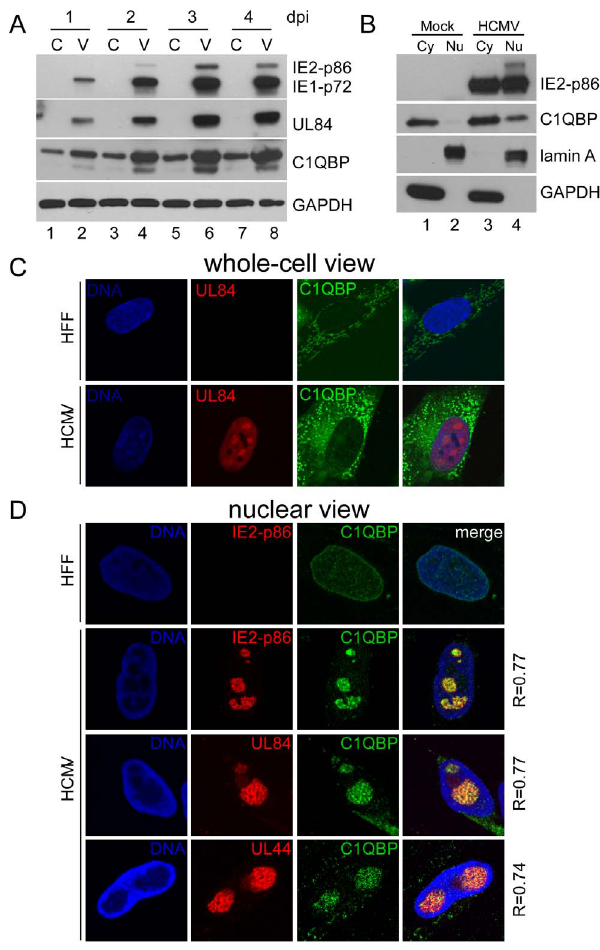
Figure 6. HCMV infection up-regulates the expression of cellular protein C1QBP, which associates with the IE2-p86/ UL84/UL44 complex in virus replication compartments. (A) HFF cells, infected with wt HCMV (V) at an MOI of 2 PFU/cell and were harvested at the indicated time-points for western blot analysis of proteins IE1-p72, IE2-p86, UL84, C1QBP, and GAPDH by using specific antibodies described in the Materials and Methods. Cellular protein GAPDH serves as sample loading control (C). (B) Cytoplasmic and nuclear fractions of mock-infected or HCMV-infected cells were analyzed for C1QBP and IE2-p86. Lamin A and GAPDH were used as makers for the nuclear (Nu) and cytoplasm (Cy) fractions, respectively. (C and D) Subcellular localization of cellular C1QBP and viral UL84, IE2- p86, and UL44 proteins in HFF cells infected with wt HCMV at MOI of 2 PFU/cell for 48 h. Uninfected cells and infected cells were fixed before (C, whole-cell view) or after (D, nuclear view) permeabilization with 0.3% Triton X-100 and immunostained with specific antibodies against C1QBP, IE2-p86, UL84, or UL44 as described in the Materials and Methods. Cellular DNA was stained by TO-PRO. The 63 6 objective lense was used. Pearson’s correlation (R) for colocalizaion of fluorescent signals was determined for indicated images by Image J software (ver 1.46) and are shown on the right of each panel.